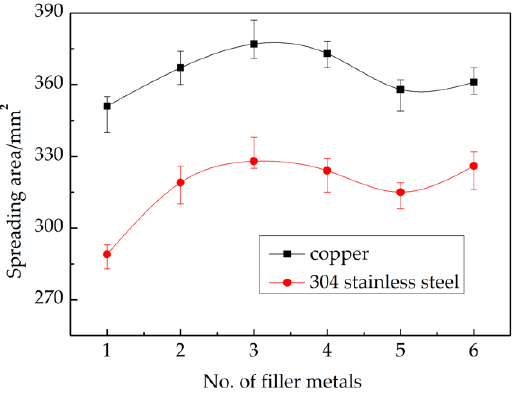
Figure 2. Spreading areas of low-silver filler metals on copper and 304 stainless steel plates.